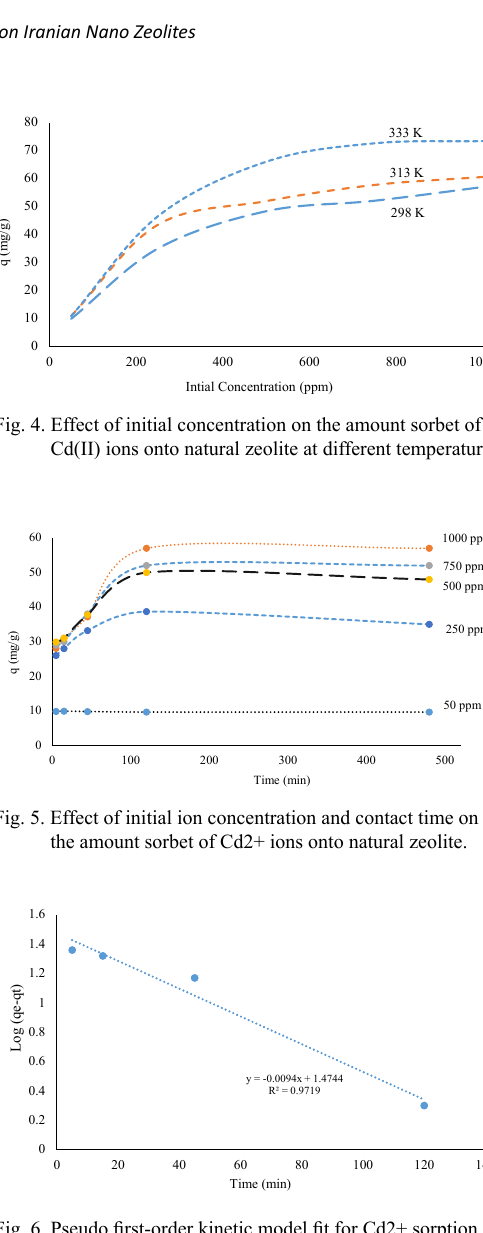
Fig. 3. TEM images of zeolite.